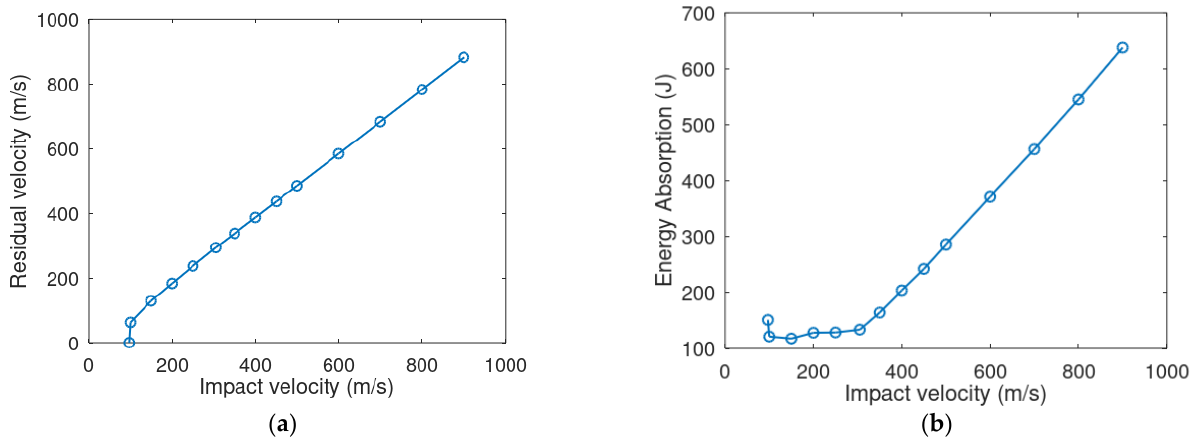
Figure 9. ( a ) Residual velocity vs. impact velocity. ( b ) Energy absorption vs. impact velocity—for 3.18 mm target thickness.